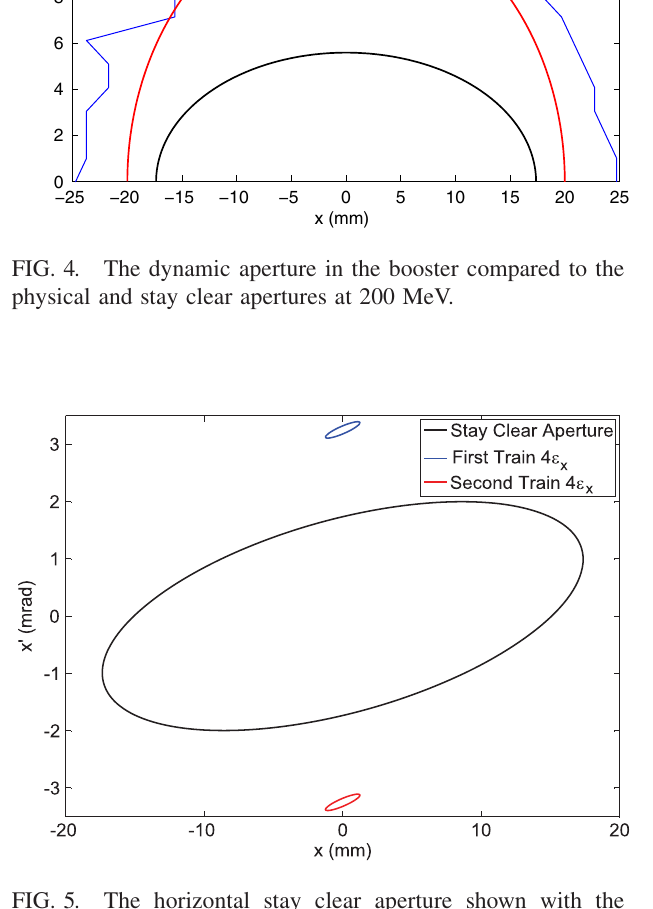
FIG. 5. The horizontal stay clear aperture shown with the stacked train phase ellipses after injection of the second bunch for the initial booster stacking scheme. Both trains lie outside of the stay clear aperture.